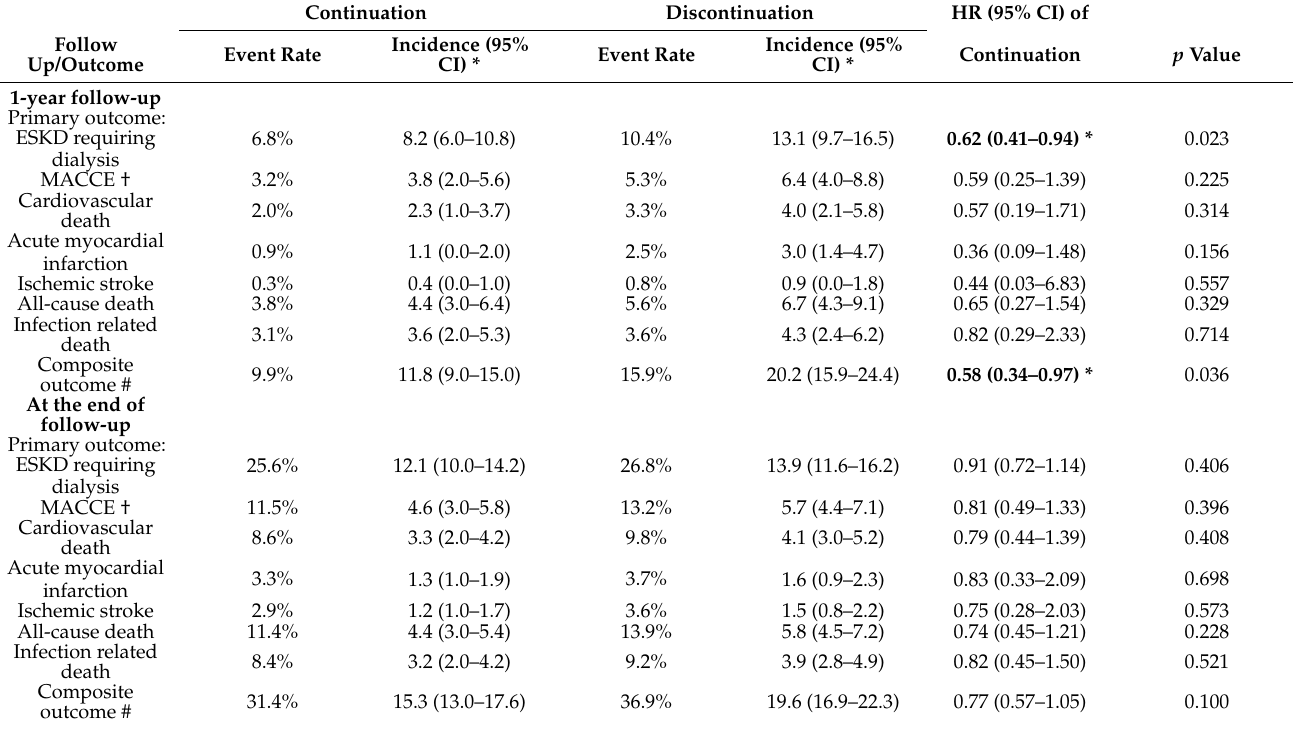
Table 3. Time to event outcomes of patients receiving ketoanalogues supplemental low protein diet in the IPTW-adjusted